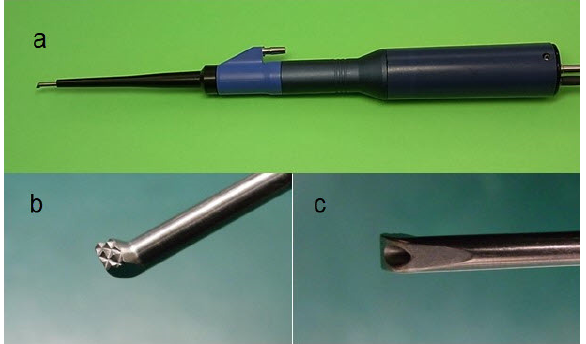
Figure 3. ( a ) Sonopet® Omni, (model UST-2001 Ultrasonic Surgical Aspirator, Stryker Corporation, Kalamazoo, Michigan, USA). ( b ) Bone removal view ( c ) Aspirator view.